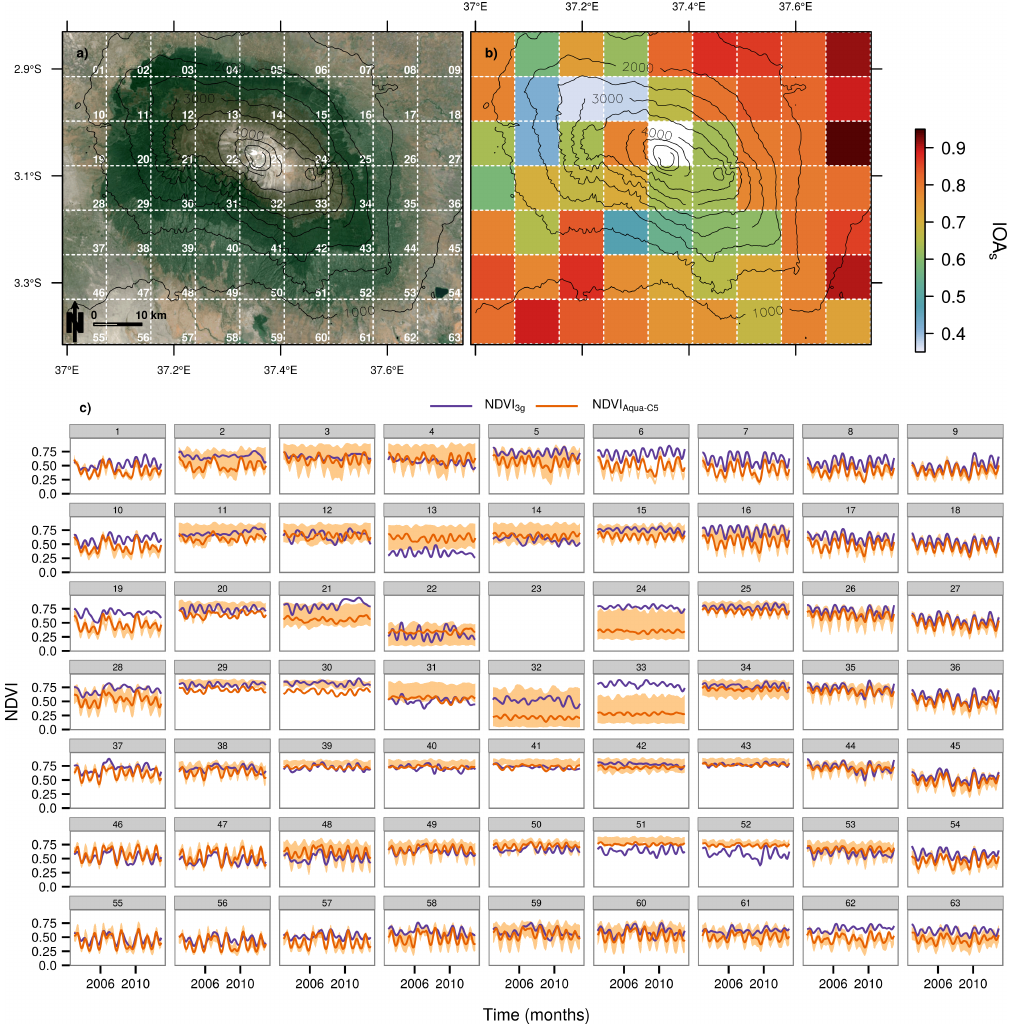
Figure 1. ( a ) Spatial coverage of the 1/12-degree GIMMS grid (white dashed) including consecutive pixel numbering superimposed upon an aerial image of the study area (Map data: Google, TerraMetrics [47]); ( b ) spatial pattern of IOA s between NDVI 3g and MODIS CMG-based NDVI Aqua-C5 (Section 2.2.1); ( c ) raw time series (2003–2012) of NDVI 3g (purple) and MODIS CMG-based NDVI Aqua-C5 (orange) including 10%–90% quantile range calculated from all 250-m NDVI Aqua-C5 pixels falling inside each 8-km GIMMS pixel (light orange). The underlying coordinate reference system (CRS) in ( a ) and ( b ) is EPSG:4326 and the digital elevation model (black solid) is based on toposheets at scale 1:50000 digitized by Ong’injo et al.